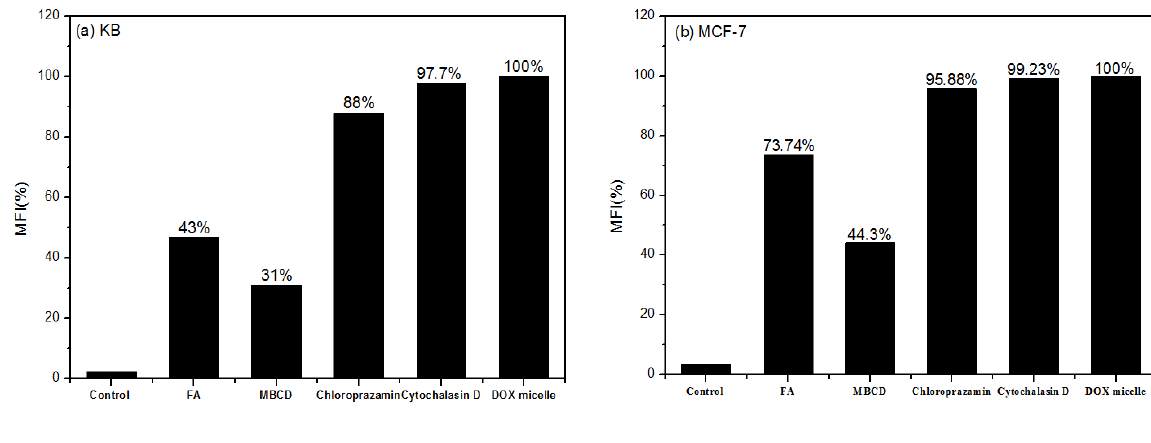
Figure 7. Effects of inhibitors on the internalization of DOX-loaded 4SPCL-PEG-Folic micelle ( a ) KB cell; and ( b ) MCF-7